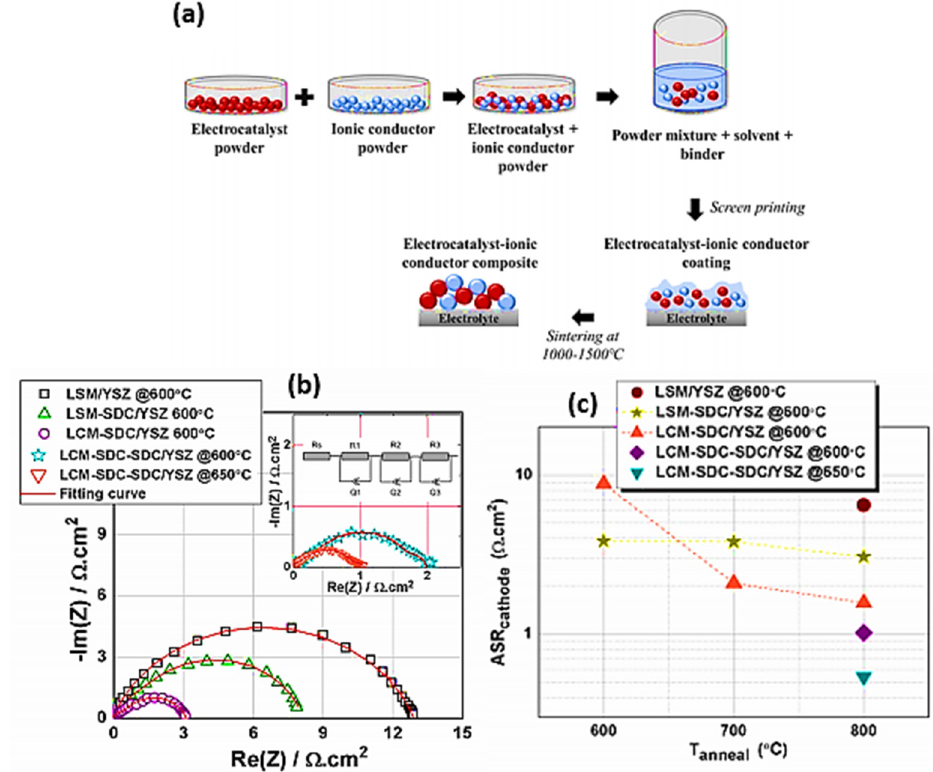
Figure 10. ( a ) Schematic illustration for the fabrication of composite cathode using powder-based precursors. ( b ) The Nyquist plot was obtained for LSM, LSM–SDC, and LCM–SDC thin film on YSZ substrates at 800 °C for 3 h and tested at 600 °C. The inset in ( b ) displays the LCM–SDC thin film on the YSZ substrate with an SDCinterlayer. ( c ) Polarization resistance of the fabricated thin films. Copyright 2019 by American Chemical Society [91].